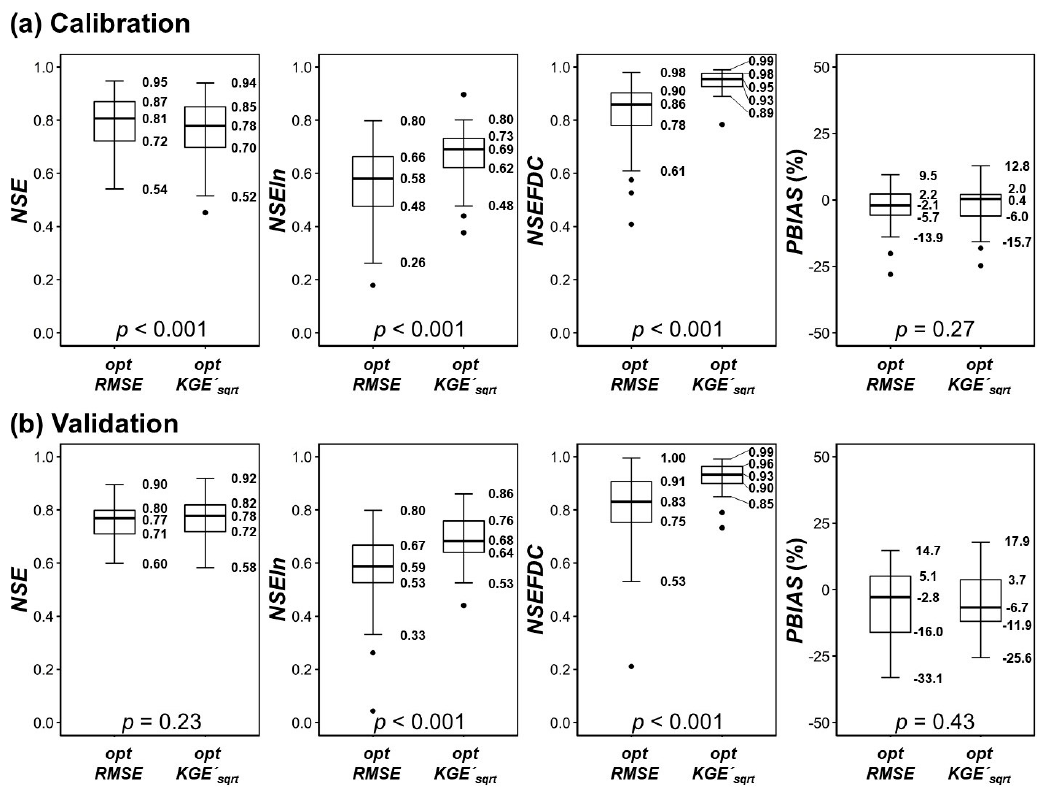
Figure 3. Comparison of performance statistics ( NSE , NSEln , NSEFDC , and PBIAS ) provided by the 3-Tank models calibrated at the outlets of 39 study watersheds with two objective functions ( optRMSE and optKGE (cid:48) sqrt ). The height of a box plot represents the interquartile range (IQR) (or the distance between the 75th and 25th percentiles), and the ends of whiskers signify the maximum and minimum values. Circles beyond the whisker ends are outliers.